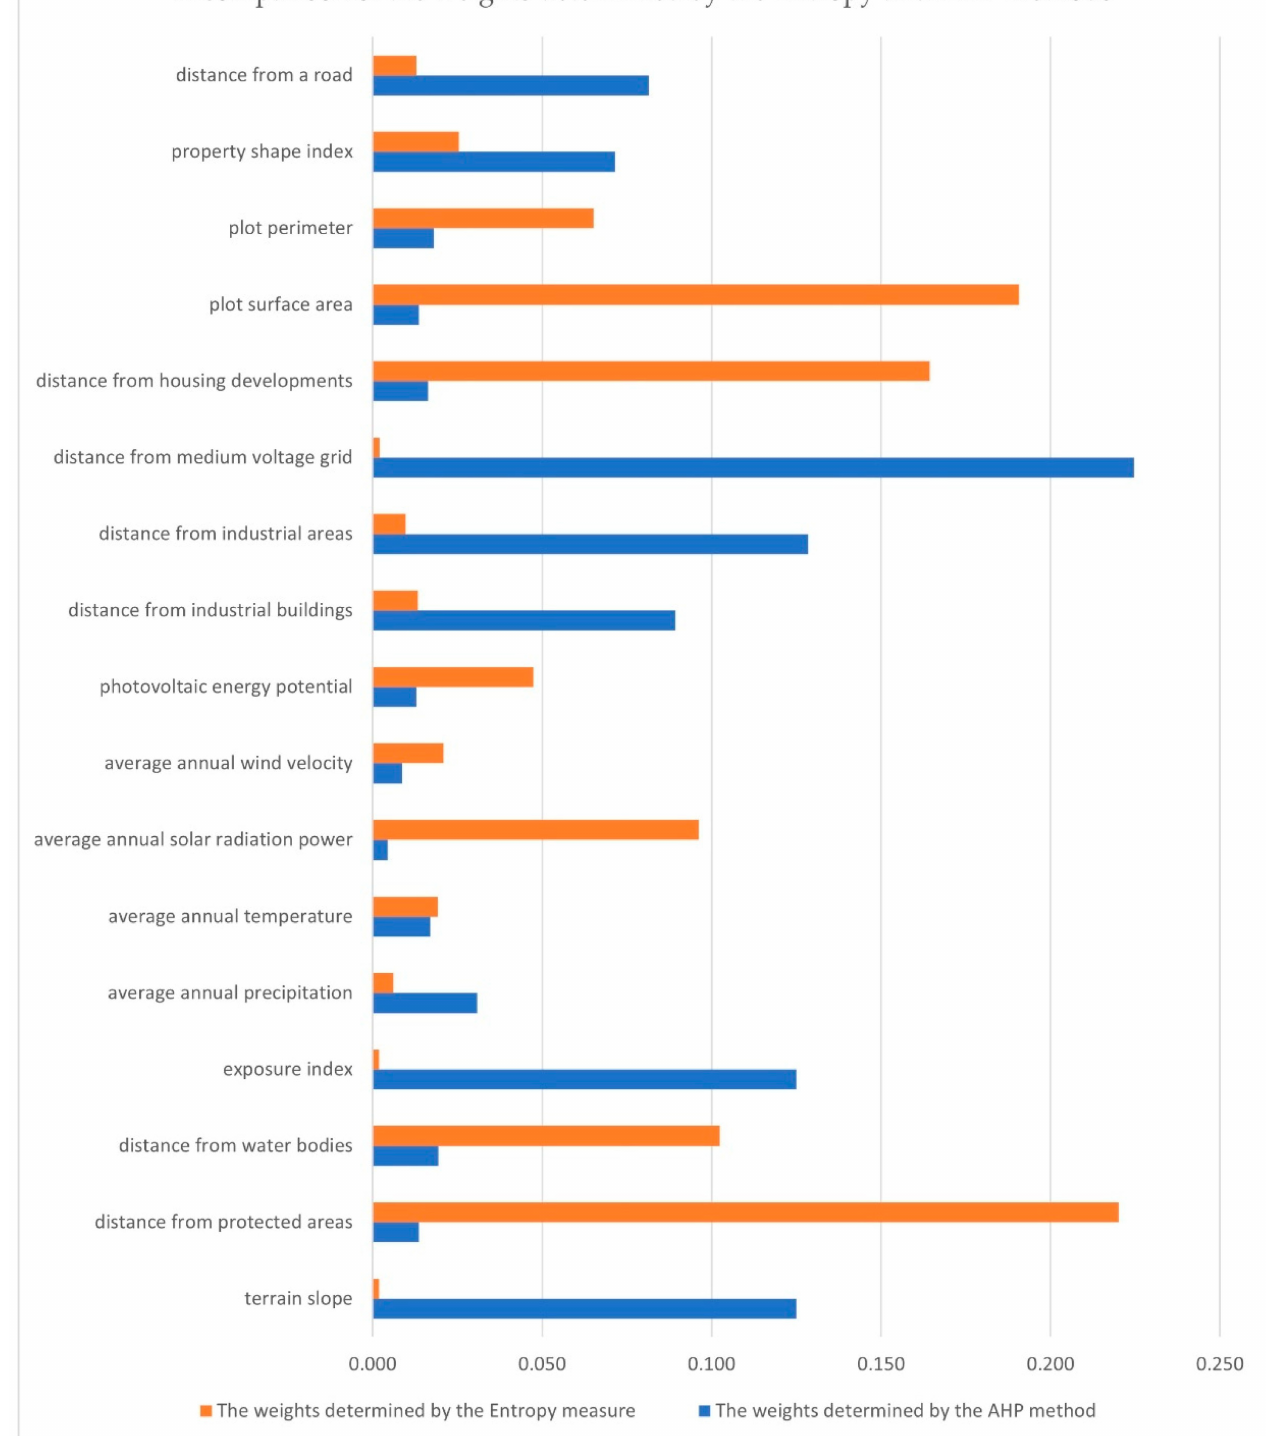
Figure 12. A comparison of the weights of the features favouring PV farm location by the Entropy and AHP